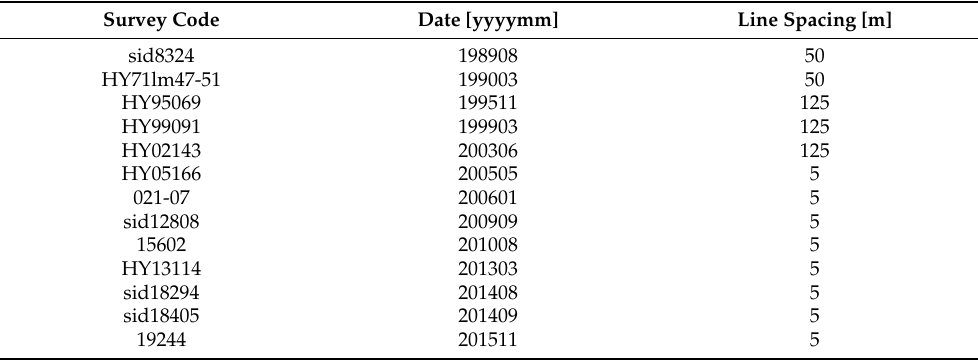
Table 2. List of surveys, SBES and MBES (indicated by the line spacing) survey code and the start date. Datasets for each sub-area vary based on available overlapping survey data. Data and further information regarding access to data source can be found at https://publicwiki.deltares.nl/display/ OET/Dataset+documentation+bathymetry+NLHO (accessed in June